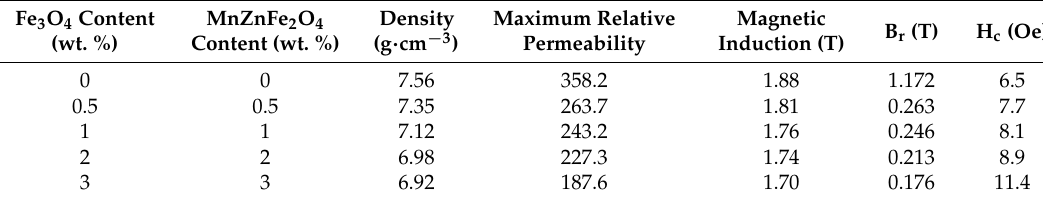
Table 2. DC performance and density for composites with different ferrite percentage. Fe 3 O 4 Content (wt.